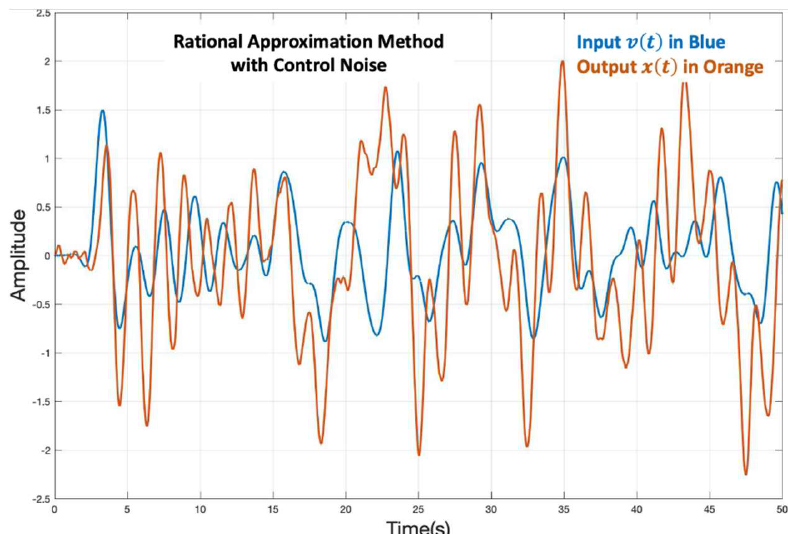
Figure 15. Response to Randomized Input (Technique 1).